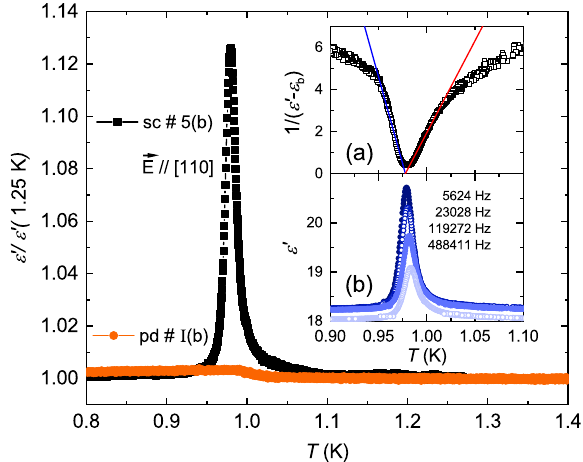
Fig. 3 Temperature dependence of the dielectric constant of PbCuTe 2 O 6 . Dielectric constant of single crystal sc #5(b) (black squares), with electric fi eld E applied along the [110] direction, and a pressed- powder sample pd # Ι (b) (orange spheres). Similar measurements on the single crystals #1(a) and #4 reveal essentially the same results albeit with a somewhat reduced peak height, see Supplementary Fig. 9 and Note 6. The inset gives details of the data for sc #5(b) in a narrow temperature range around 1K. Inset a , showing 1/( ε ’ − ε ’ b ) vs. T , re fl ects a Curie – Weiss-like behavior on approaching the maximum in ε ’ from both sides. The slopes of the linear regimes differ by a factor of about − 1.9. This factor is very close to − 2, expected for a mean- fi eld second- order ferroelectric transition 43 , but strongly departs from − 8 seen at fi rst-order ferroelectric transitions 25,44 . The lower inset b shows ε ’ vs. T for varying frequencies as indicated in the fi gure. The small shift of the background dielectric constant ε ’ b , visible for the data at highest frequency, indicates some contribution from extrinsic factors.